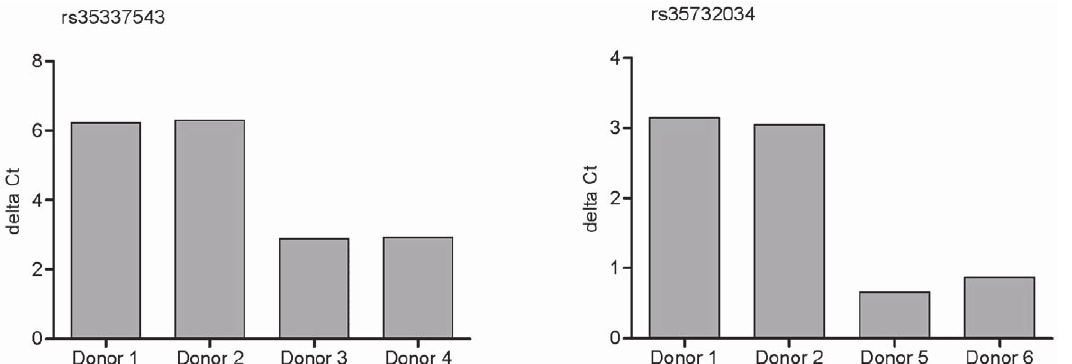
Figure 2. Detection of aberrant splicing of IFIH1 mRNA for the two rare SNPs predicted to alter splicing. Levels of IFIH1 pre mRNA and spliced RNA transcript were measured using qPCR assays designed to the corresponding exon to intron and exon to exon sequence. The delta Ct is calculated using the pre mRNA transcript Ct minus the mRNA transcript Ct. A larger delta Ct indicates more pre-mRNA and less mRNA transcript of IFIH1 . Donor 1 and 2 are control individuals, donor 3 and 4 heterozygous for rs35337543 (IVS8 + 1) and donor 5 and 6 are heterozygous for rs35732034 (IVS14 + 1).